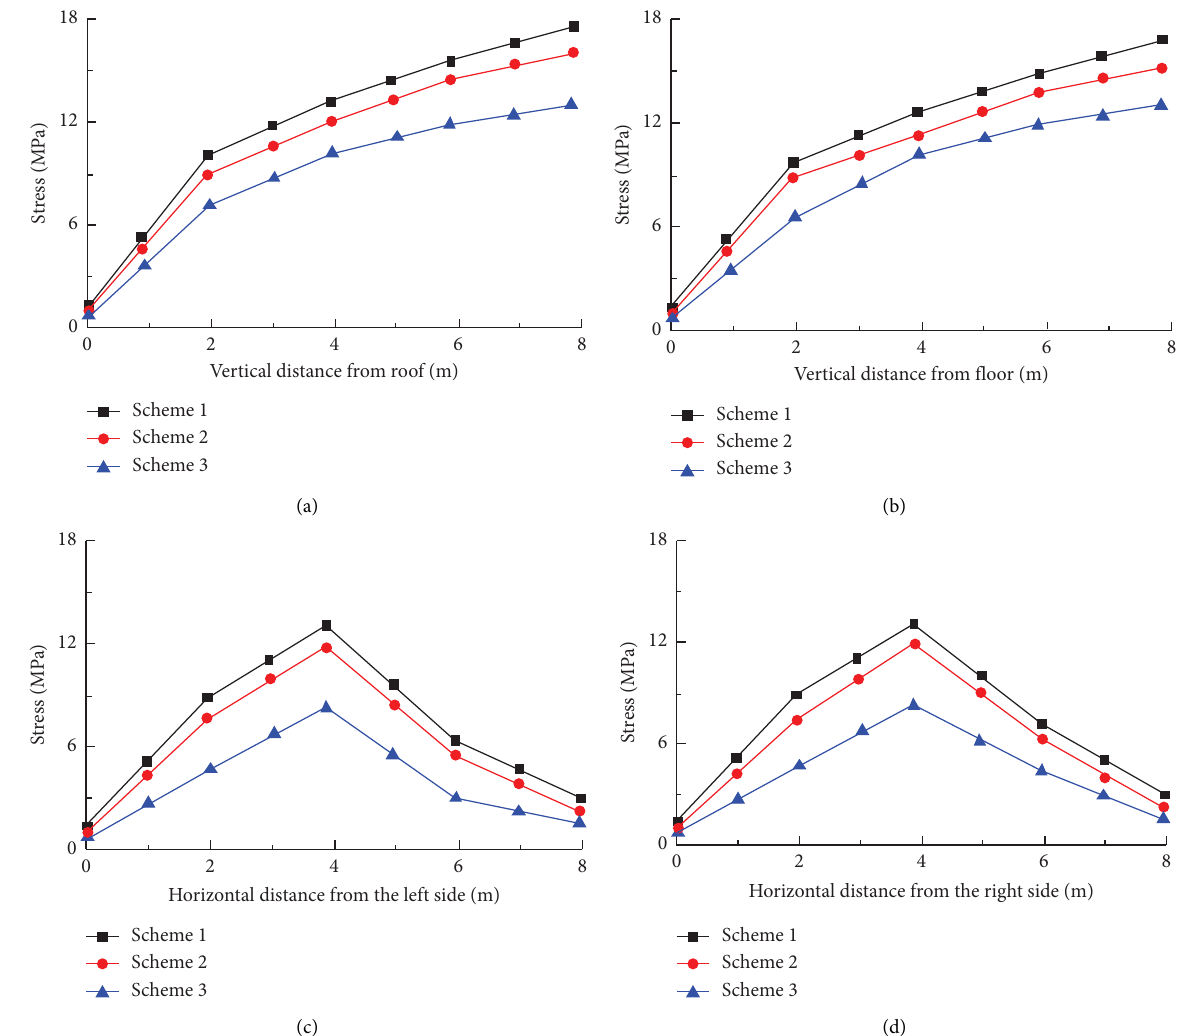
Figure 13: Stress at diferent positions of roadway. (a) Diferent positions of roof, (b) diferent positions of foor, (c) diferent positions of left side, and (d) diferent positions of right